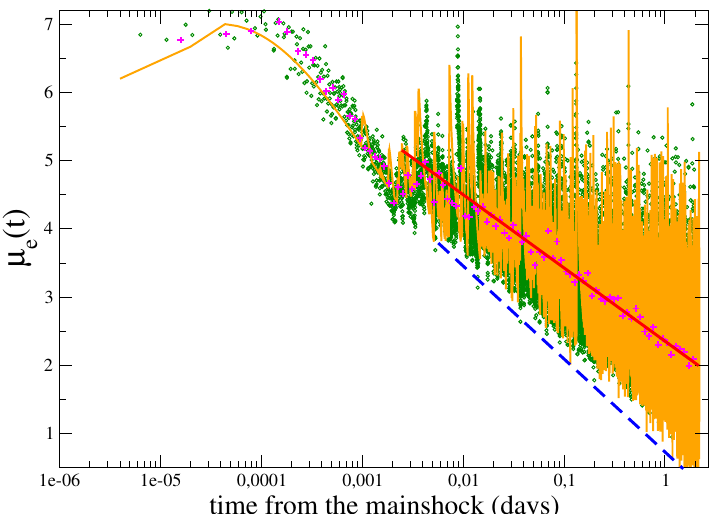
Figure 8. The quantity µ e ( t ) (green circles) after the the Hector Mine earthquake in California recorded at the station CIGSC located at a distance of 92 km from the main shock epicenter. The magenta crosses indicate the (logarithmically binned with bin value 0.1) average value of µ ( t ) , the red continuous lines represent the results of the logarithmic fit (Equation (13)) for t − t 0 > t M . The dashed blue lines represent the quantity µ min ( t ) and orange lines are used for results of numerical simulations for the theoretical envelope µ th ( t ) , defined in Equation (15). The values of the best-fitting parameters in Equation (6) are K = 0.95, c = 0.18 days and τ = 8